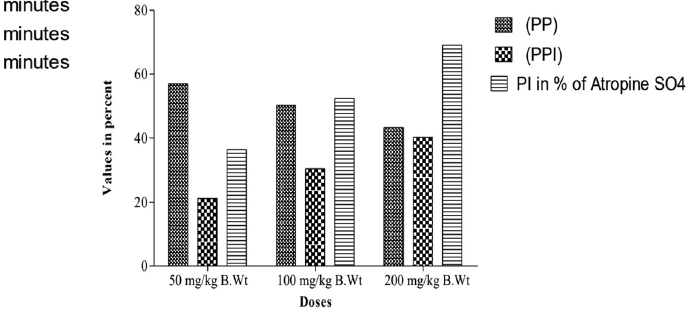
Figure 9: Spasmolytic e ffi cacy of SE - mediated AuNPs, showing GI propulsion inhibition under di ff erent dose